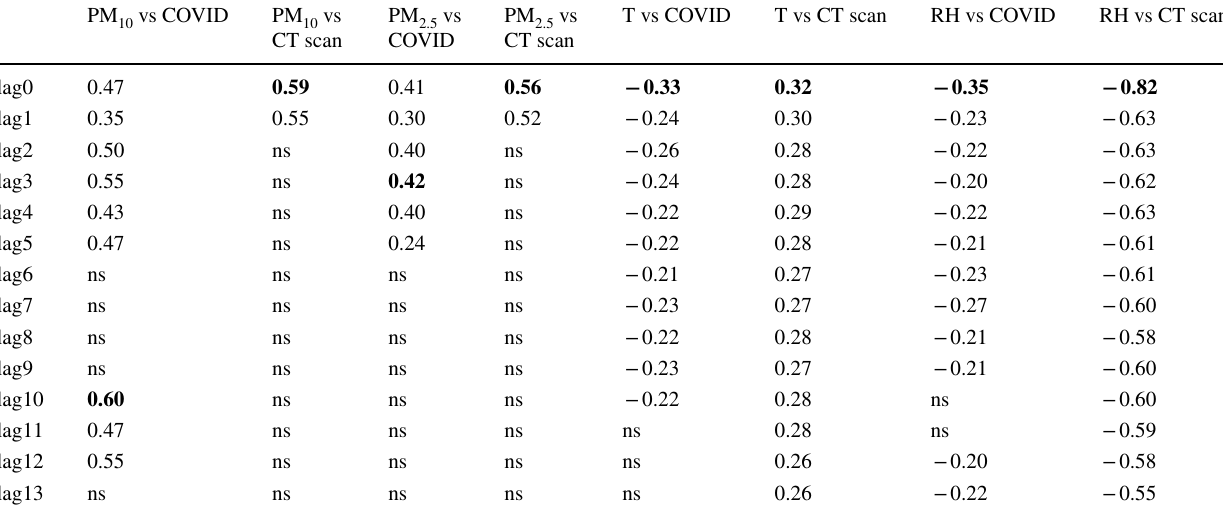
Table 4 Correlation coefficient (Spearman’s test) between daily PM 10 and PM 2.5 mean concentrations, air temperature, and relative humidity with positive chest CT scan and COVID-19 cases at different time lags (0–13 days)